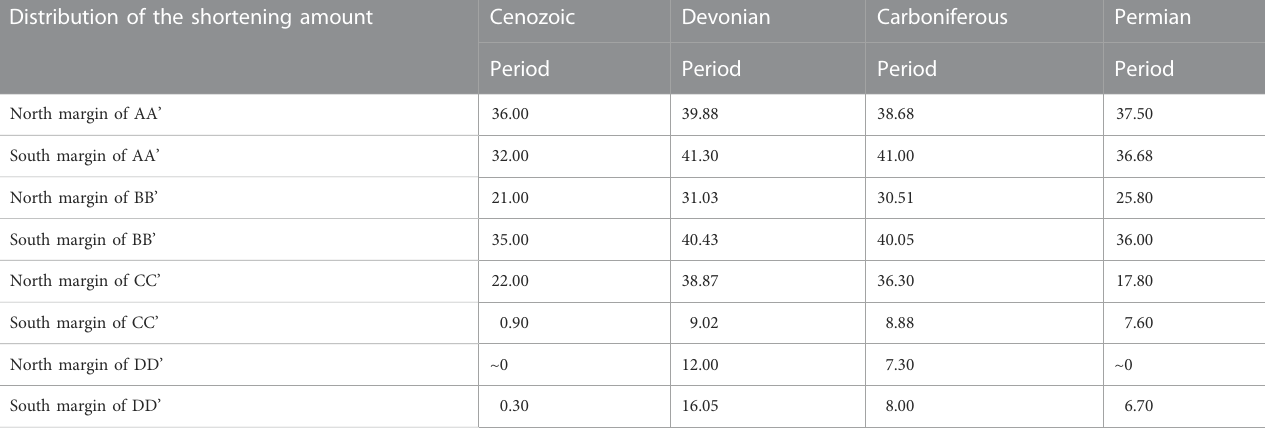
TABLE 1 Shortening amount of Tarim Basin between Devonian, Carboniferous, Permian Periods and present (/km). Distribution of the shortening